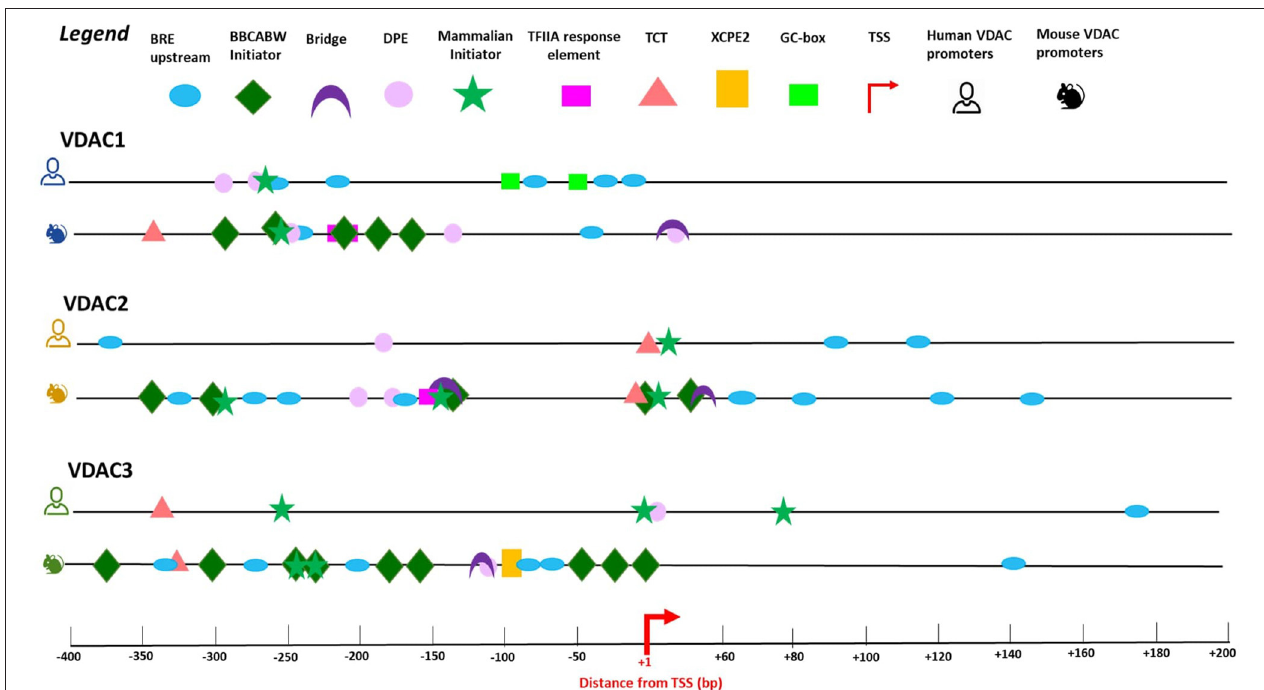
FIGURE 3 | Promoter binding motifs and their location in human and mouse VDAC genes. The promoter sequences of mVDAC1, mVDAC2, and mVDAC3 genes used in this work cover a wider region around the TSS compared with the annotated core promoter in EPD database (EPD new v.006), ranging from 400bp upstream the TSS to 200bp downstream the TSS. The promoter elements identified by the predictive tool ElemeNT v.2 (http://lifefaculty.biu.ac.il/gershon-tamar/index.php/ resources) illustrated in the legend box are B recognition element (BRE); BBCABW, Mammalian initiator, Bridge motif, downstream core promoter element (DPE), TFIIA response element, polypyrimidine initiator (TCT), and X core promoter element 2 (XCPE2). The TSS site is indicated by a red arrow. The scheme displays the similarity (conserved motifs) and differences in the structure and distribution of mouse promoter elements with the results of promoter elements in human VDAC genes ( Zinghirino et al., 2020). Each promoter binding motif was chosen with highest scoring consensus based on functionally recommended scores of ≥ 0.1 for BBCABW Initiator, Human TCT and TFIIA response element; ≥ 0.01 for Bridge, DPE, MTE, XCPE 1, and XCPE 2. The human output might be less informative than mouse representation due to a quality operating filtering. Few elements were found with a maximum score due to a redundancy of human promoter